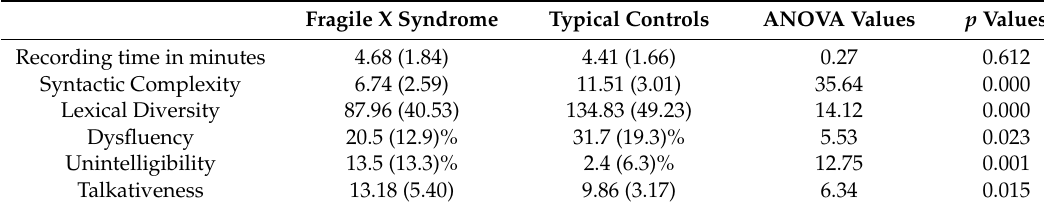
Table 2. Expressive language sampling (ELS) between-group